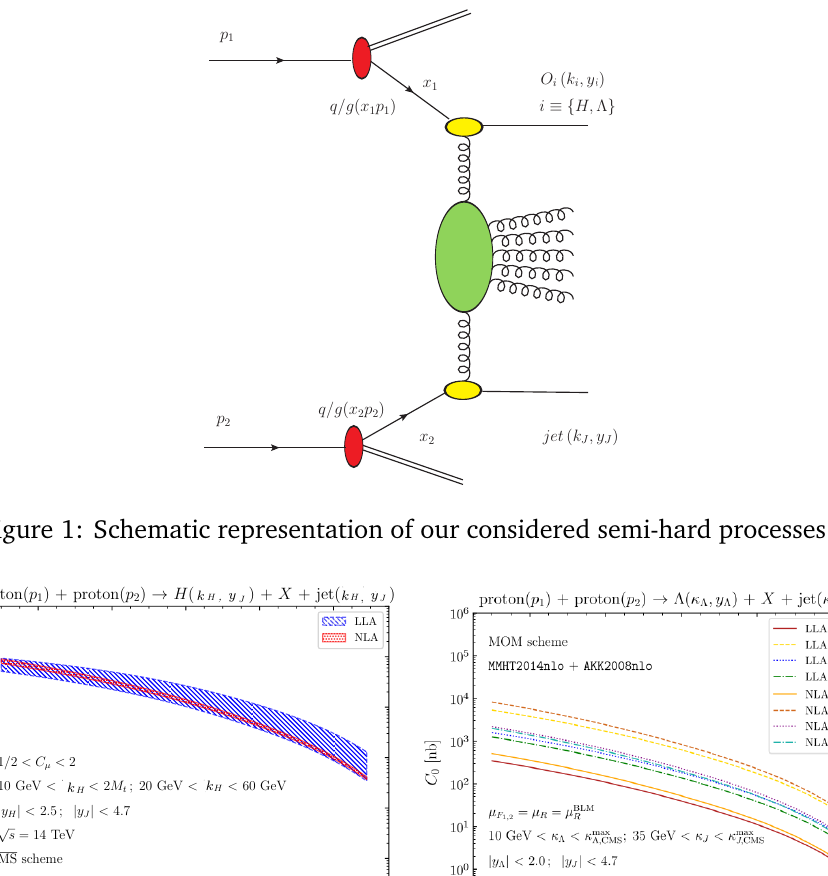
in the symmetric p 0